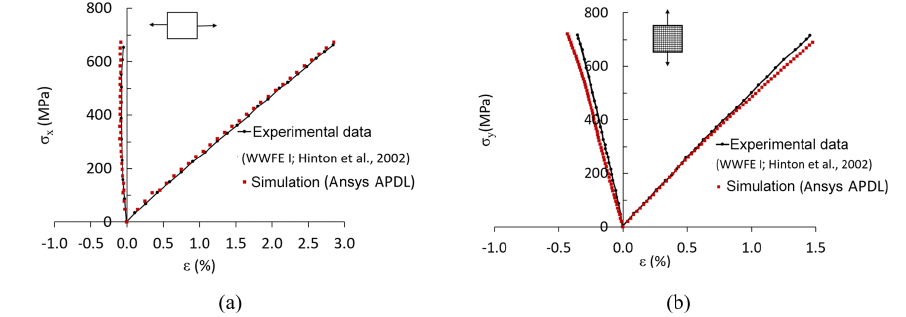
Figure 4. Validation of the APDL code for the progressive failure analysis of (a) [ 0 / 90 ] s GFRP MY750 laminate under σ x uniaxial tension and (b) [ 0 / ± 45 / 90 ] s CFRP/AS4 3501-6 laminate under σ y uniaxial tension (Hinton et al., 2002).